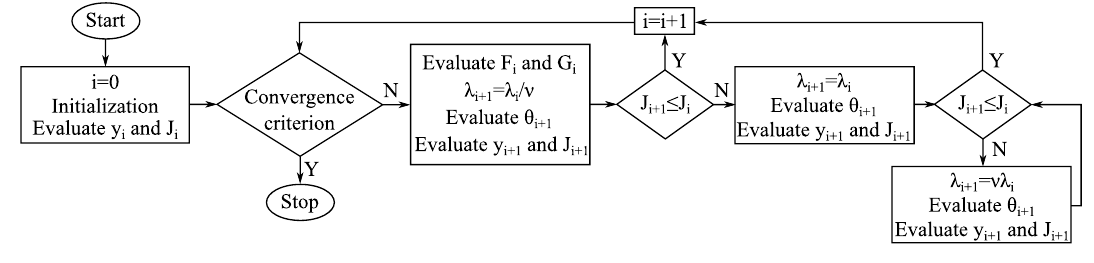
Figure 8. Optimization